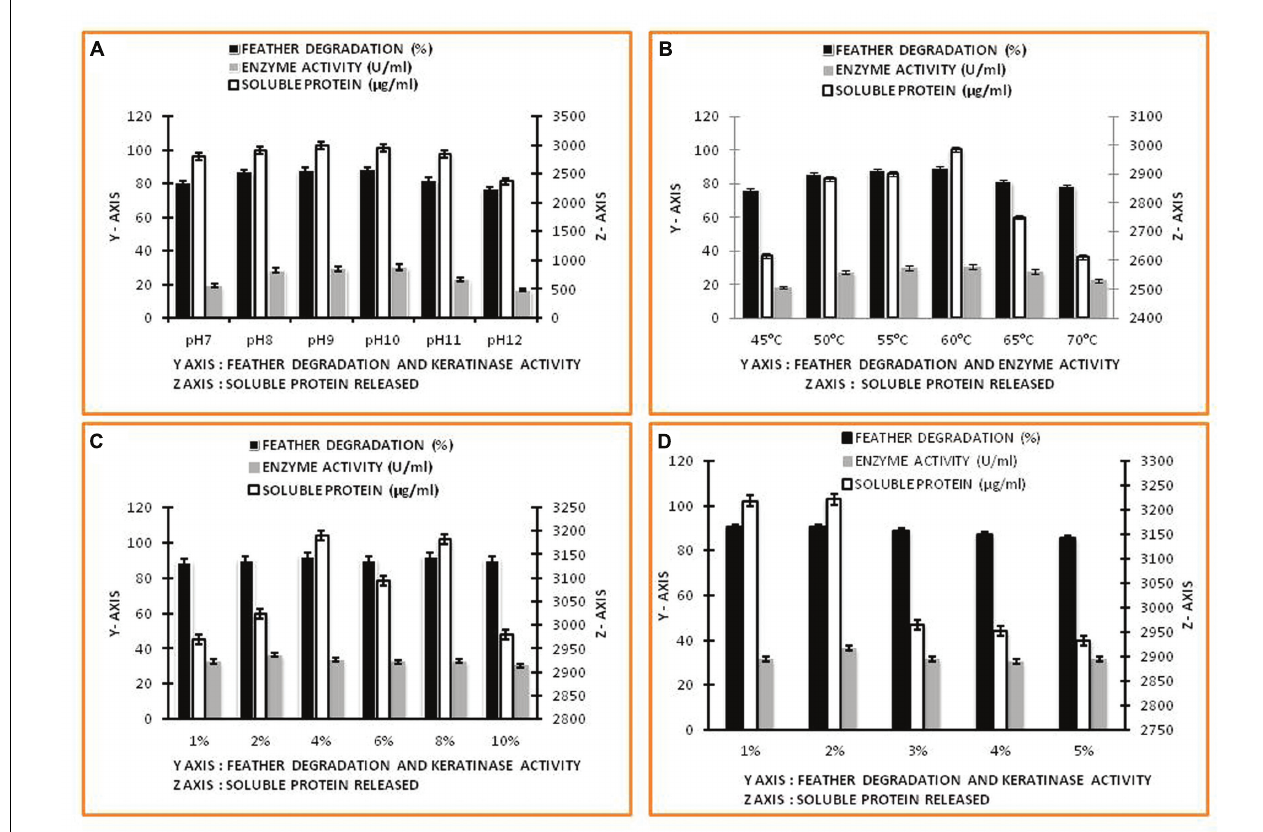
FIGURE 2 | Factors affecting keratinase enzyme production and feather degradation in keratinase production media. (A) Effect of pH; (B) Effect of temperature; (C) Effect of inoculum percentage; (D) Effect of feather